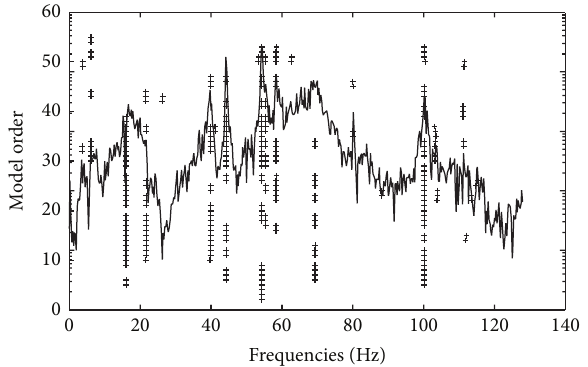
Figure 4: The aircraft stabilization diagram with classical imple- mentation.